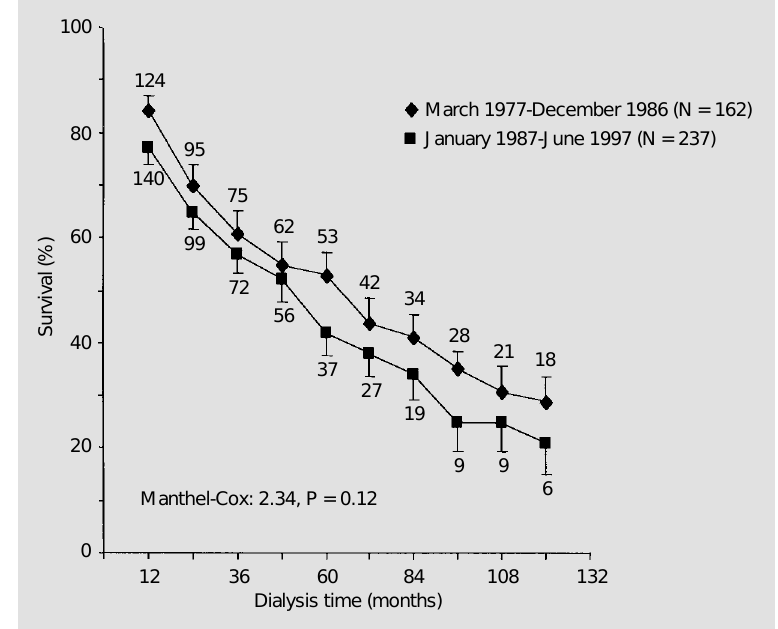
Figure 1 - Kaplan-Meier survival curves for patients on dialysis from March 1977 to December 1986 (N = 162; lozenges) and from January 1987 to June 1997 (N = 237; squares). Bars indicate the SEM. Numbers over or under the bars indicate number of patients at risk at the beginning of each time interval for each group.